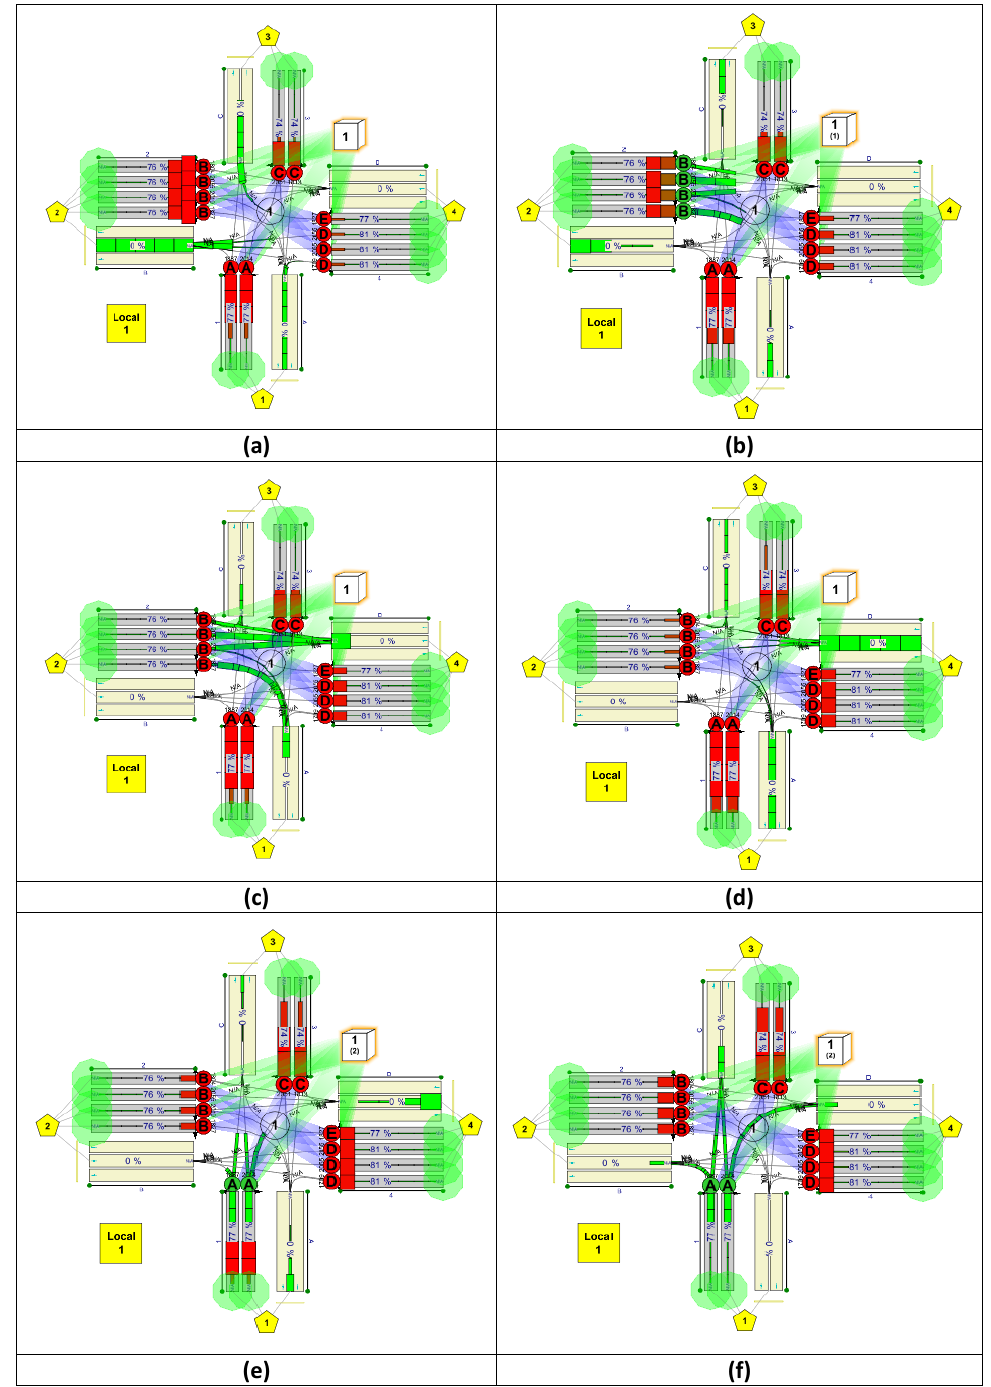
Figure 10. Simulation results for the morning-peak period. Simulation time ( a ) 0 s; ( b ) 5 s; ( c ) 10 s; ( d ) 15 s; ( e ) 20 s; ( f ) 25